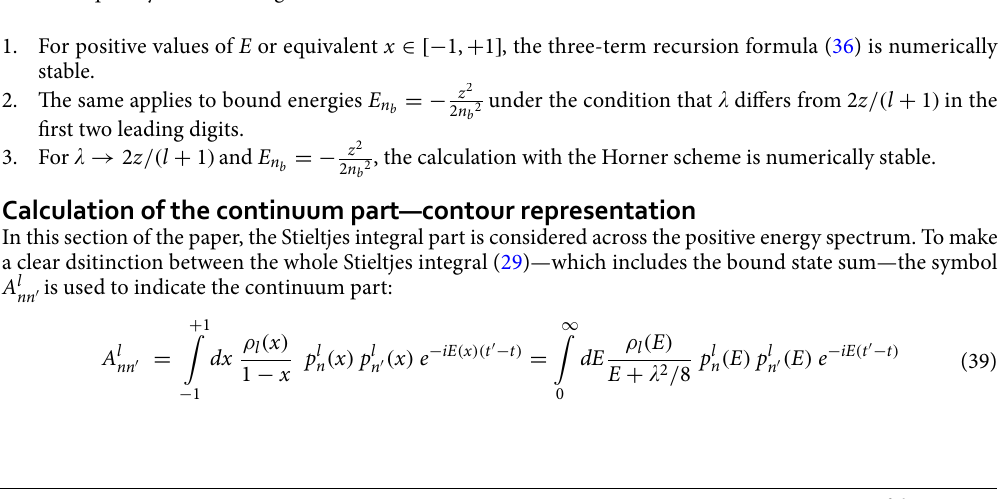
12 14 using the Horner scheme